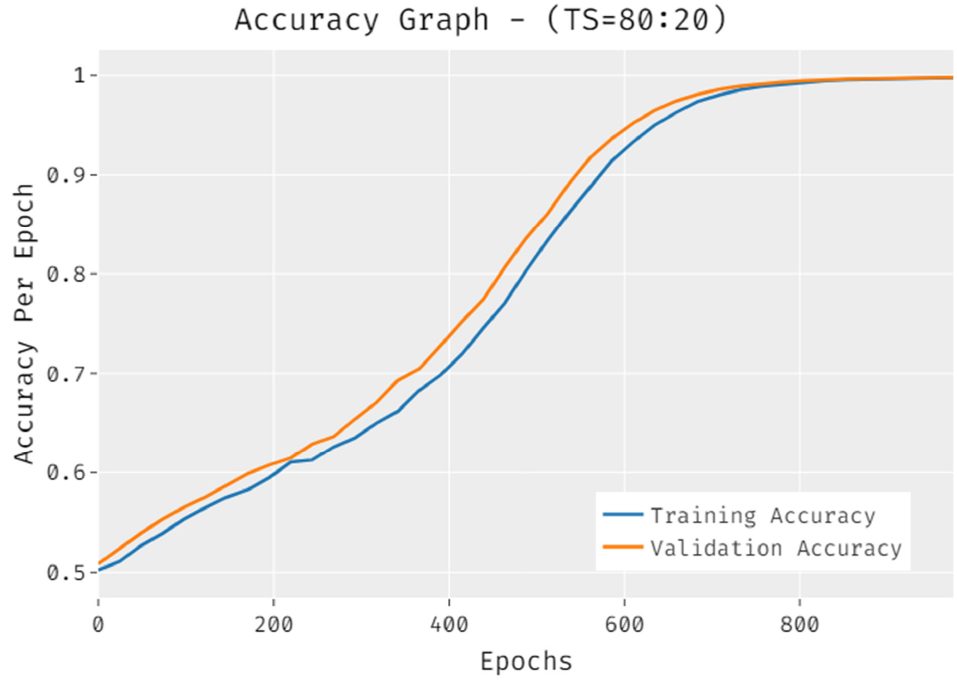
Figure 4. Accuracy of IDLDMS-PTC technique under training set (80:20). The loss outcome analysis of the IDLDMS-PTC technique under training set (80:20) data is depicted in Figure 5. The figure exposed that the IDLDMS-PTC technique has de- noted the reduced validation loss over the training loss. It can be additionally observed that the loss values get saturated with the count of epochs.